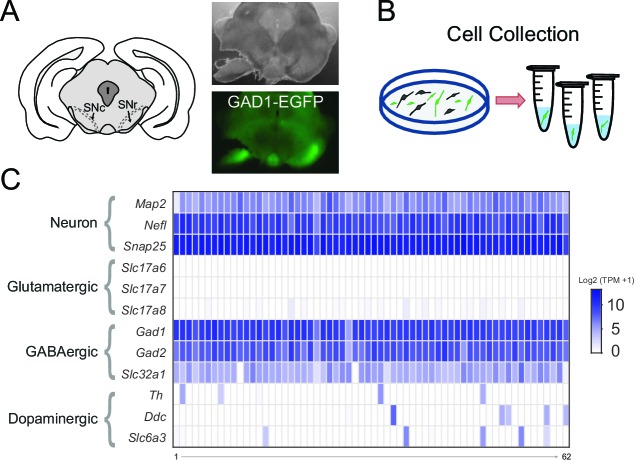
Transcriptome sequencing of individual SNr GABAergic neurons.(A) (left) Drawing depicting a coronal section of the mouse brain containing the substantia nigra pars compacta (SNc) and SNr. Bright field (right top) and green fluorescent (right bottom) images of a coronal brain section from a GAD1-EGFP mouse with the substantia nigra region of one hemisphere partially microdissected. (B) Scheme for the plating and collecting of individual GFP-positive neurons. (C) Gene expression results for the 62 samples that were of high quality. The rows indicate gene expression results for neuron specific marker genes (Map2, Nefl, Snap25) and marker genes for neuronal subtypes: glutamatergic (Slc17a6, Slc17a7, Slc17a8), GABAergic (Gad1, Gad2, Slc32a1), and dopaminergic (Th, Ddc, Slc6a3). Expression is indicated by the log2 transform of the number of transcripts per million (TPM) plus 1.